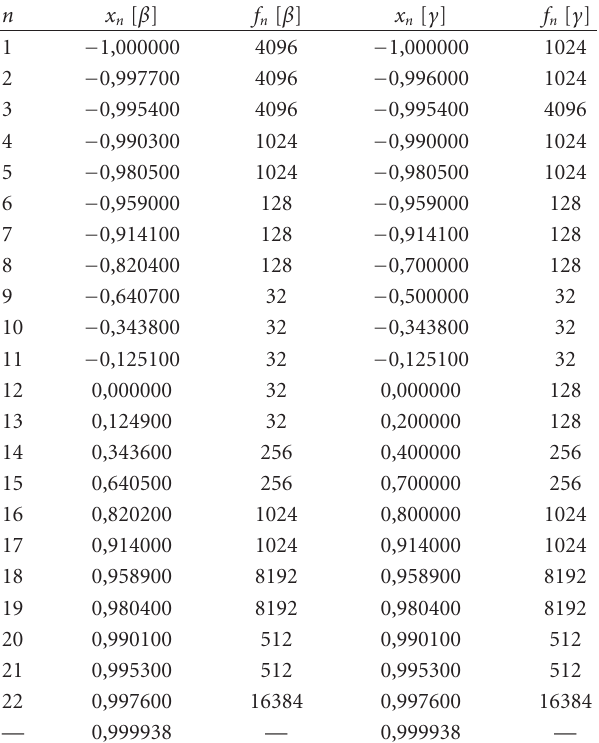
Table 4: Frequency assignment for sampling schemes β and γ .